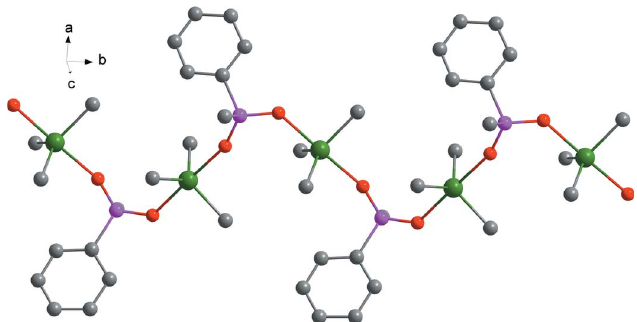
Figure 2 View of the one-dimensional zigzag chain structure running parallel to the b axis in the title compound. H atoms have been omitted for